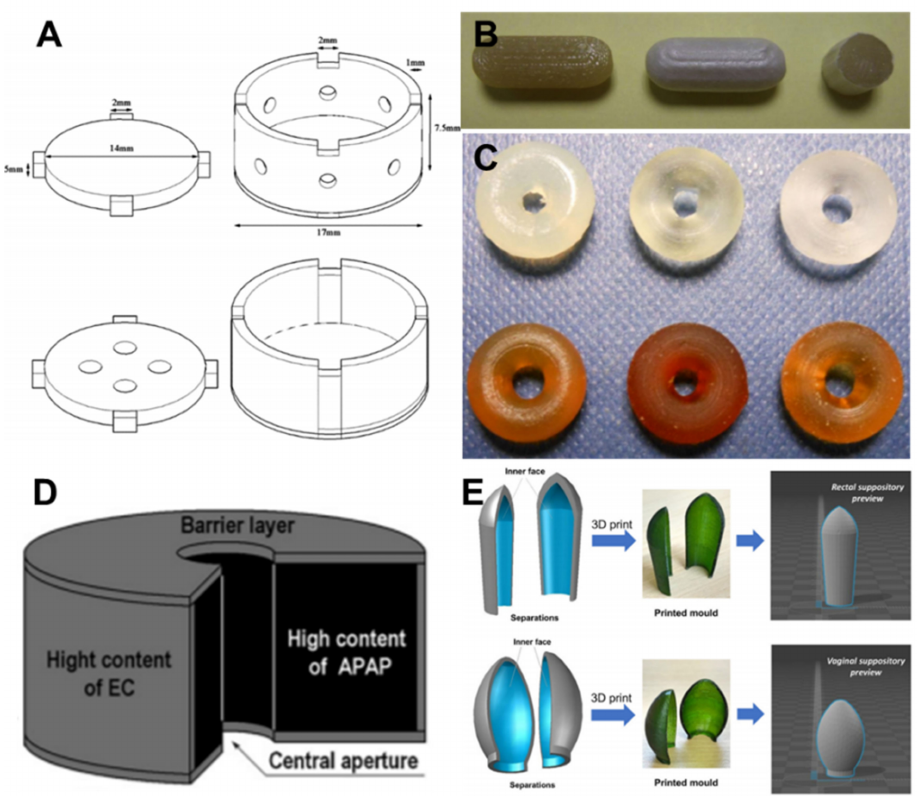
Figure 6. Representative examples of 3D printed oral/vaginal/rectal drug delivery systems. ( A ) 3D model of the carbamazepine-loaded oral drug device for tonic seizures. Reproduced with permission from [180], Elsevier, 2016. Photograph of 3D printed oral drug carriers loaded with ( B ) budesonide (reproduced with permission from [183], Elsevier, 2015), ( C ) (upper) paracetamol, and (lower) 4-aminosalicylic acid (4-ASA). Reproduced with permission from [184], Elsevier, 2016. ( D ) Schematic illustration of torus-shaped multi-layered drug delivery device. Reproduced with permission from [185], Elsevier, 2009. ( E ) Computer-aided designs of suppository molds for (upper) rectal and (lower) vaginal and rectal routes. Reproduced with permission from [186], Elsevier,